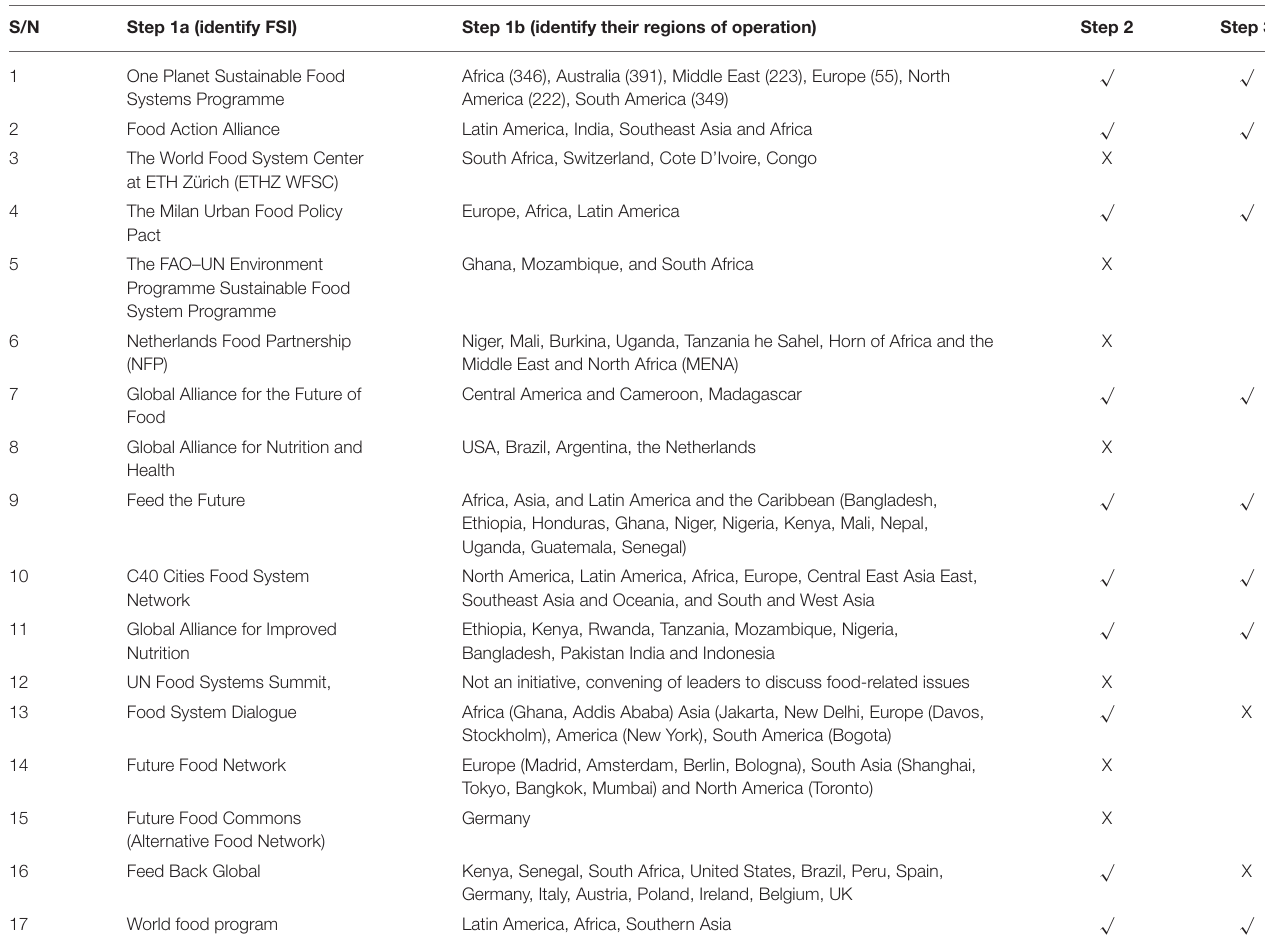
TABLE 6 | The three-step methodology for selecting FSI. S/N Step 2 Step